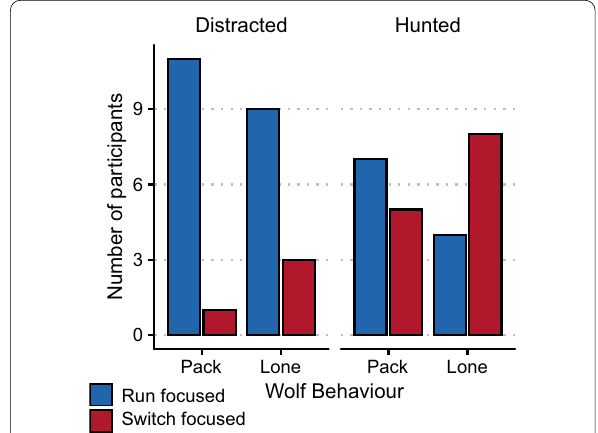
Fig. 4 Frequency of foraging strategy as a function of Predation group (Distracted/Hunted) and Wolf Behaviour (Pack/Lone) in Experiment 1. See text for